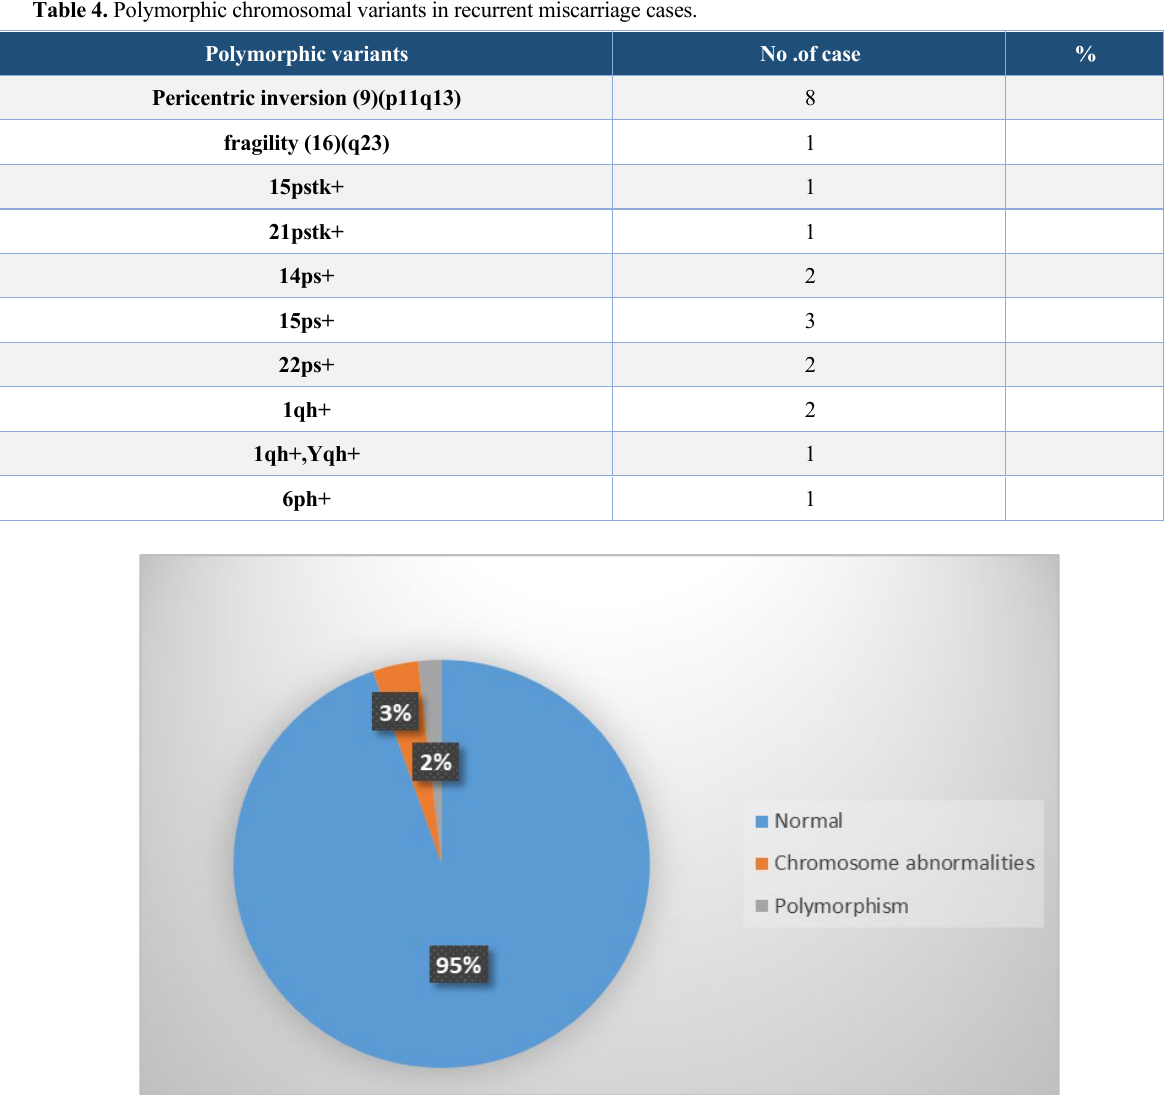
Table 4. Polymorphic chromosomal variants in recurrent miscarriage cases.